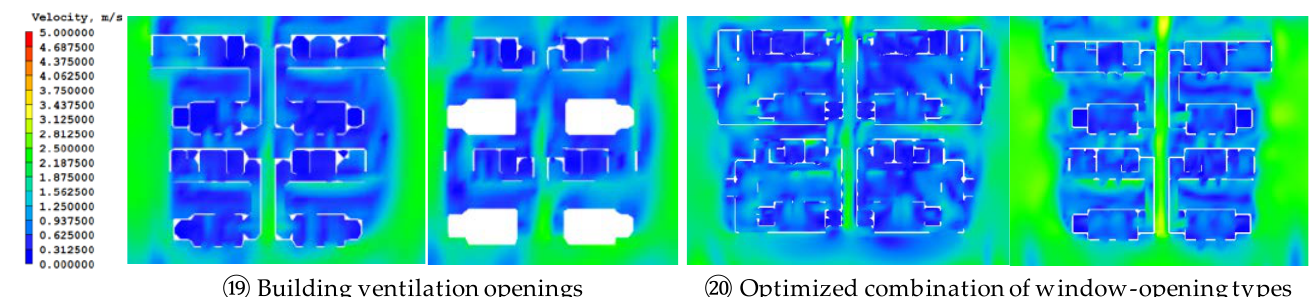
Figure 14. Comparison of simulation for optimization of building ventilation